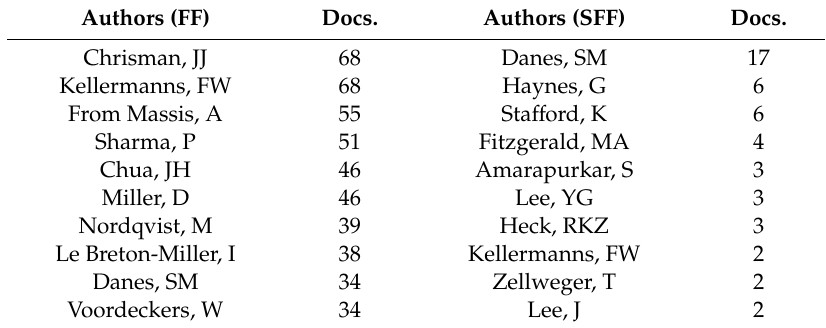
Table 4. Authors who have published on Family firms or on Sustainability in Family